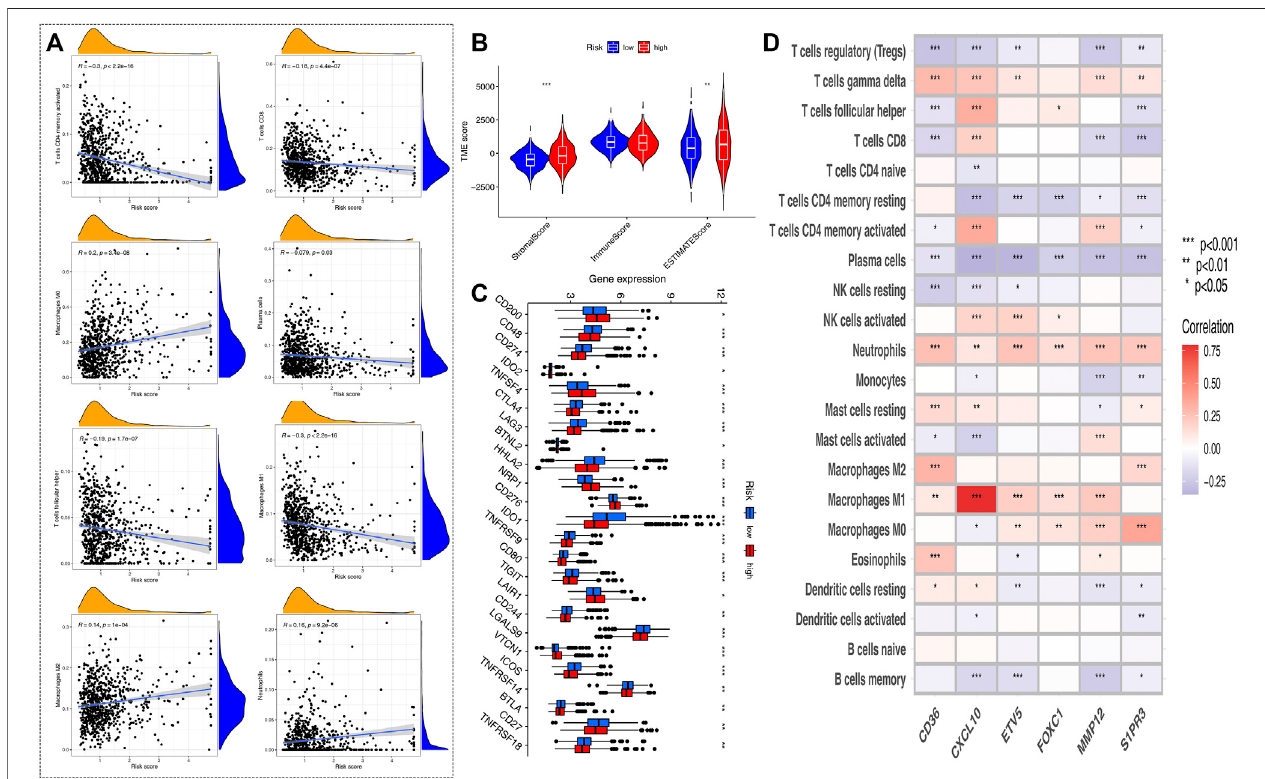
FIGURE 6 | Evaluation of the TME and checkpoints between the two risk groups. (A) Correlations between HRG-score and immune cell types. (B) Correlations between HRG-score and TME score. (C) Expression of immune checkpoint-related genes in the low- and high-risk groups. (D) Correlations between the relative abundance of immune cells and six genes involved in the HRG-score. (* p < 0.05; ** p < 0.01; *** p <